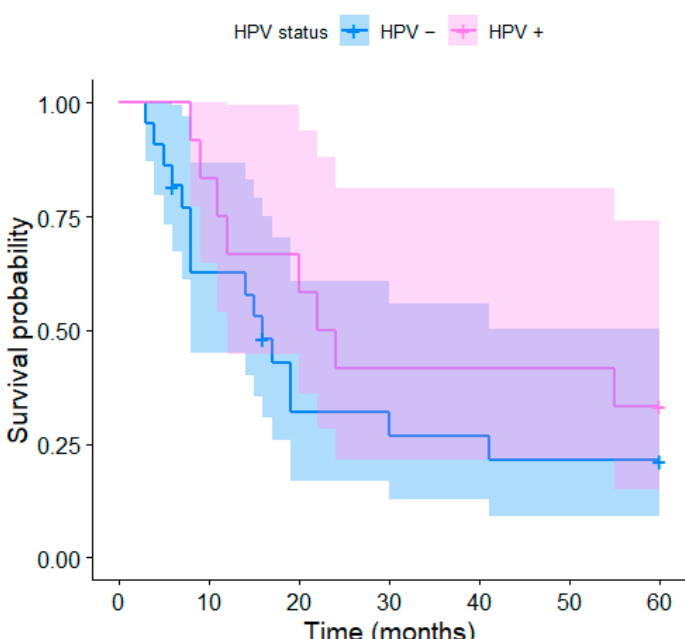
Figure 3. Kaplan–Meier curves of the 5-year survival for HPV+ and HPV − patients.